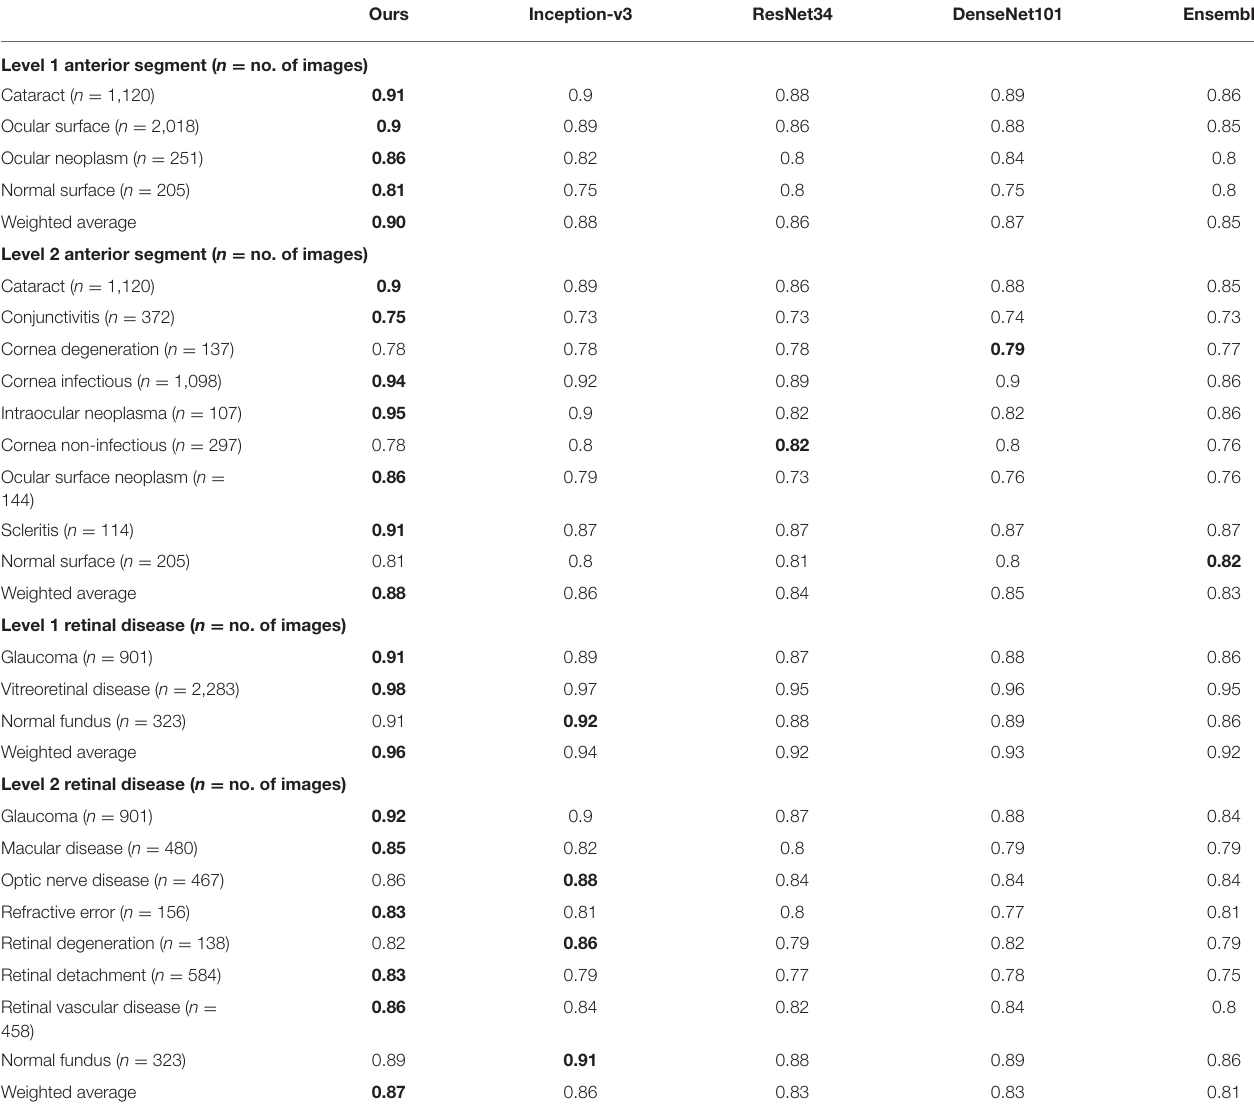
TABLE 4 | Recall comparison between the proposed hierarchical deep learning framework and existing deep learning frameworks. Ours Inception-v3 ResNet34 DenseNet101